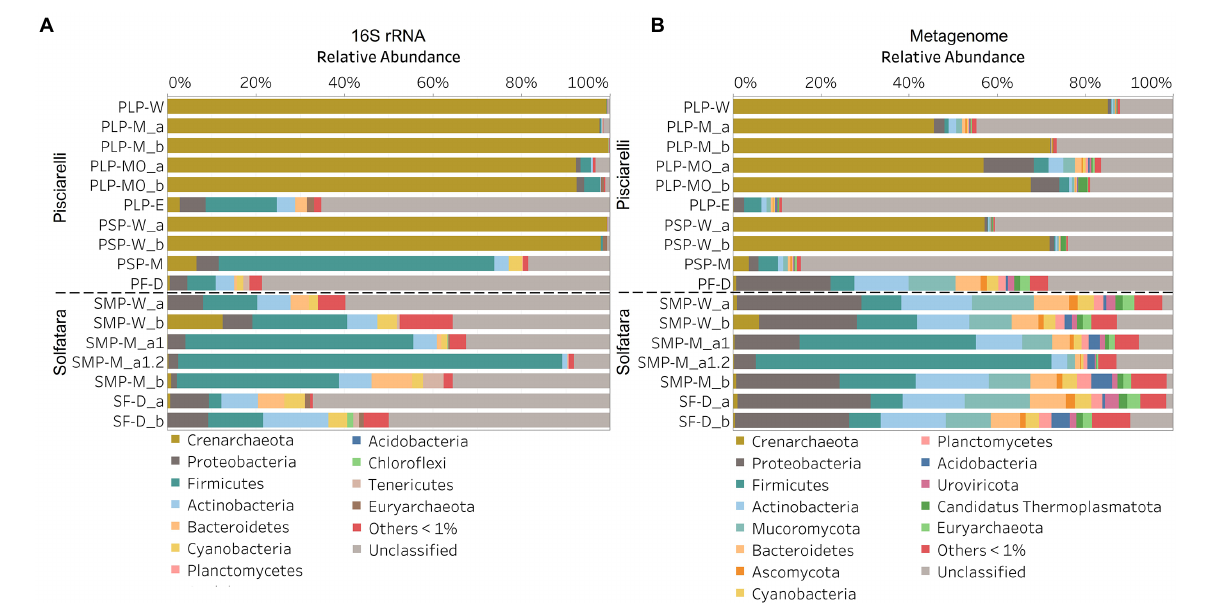
FIGURE 3 Relative abundance of phyla based on (A) metagenome-derived 16S rRNA gene and (B) metagenomic profiling. Relative abundance was calculated after removing sequences that were unclassified at the domain level, kitome, singleton, species present in only one sample and low abundance species. Phyla with average abundance of <1% were grouped into Others <1%. W represents water, M for mud, MO for mud outlet, E for epilithic microbial layer from dry mud, and D for fumarolic deposits samples. Samples labeled a and b are replicates sampled from the same spot. Sample SMP-M_a1 and SMP-M_a1.2 are sequencing